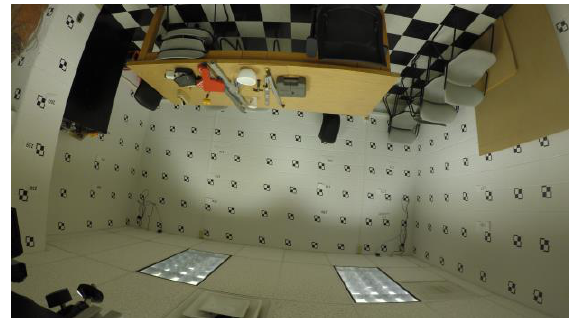
Figure 8. A frame from GoPro video from the calibration